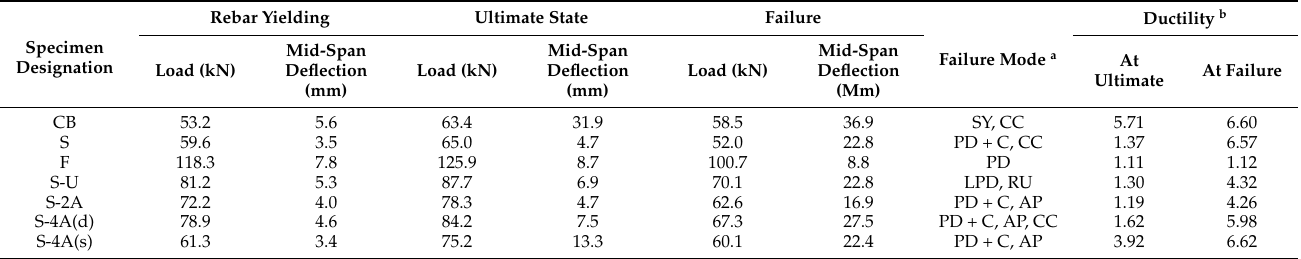
Table 4. Summary of test